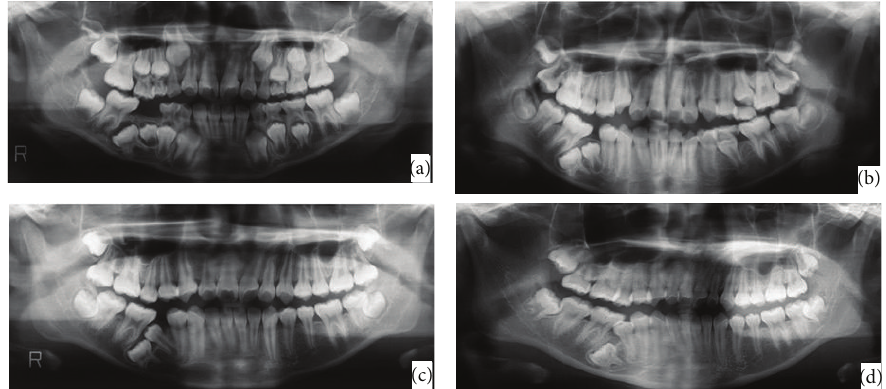
Figure 6: Panoramic radiographs showing growth changes of the dental germ: case 2. The formation stages of the impacted permanent tooth were approximately (a) Ri at age of 9 years and 2 months, (b) R1/2 at age of 11 years and 0 months, and (c) R3/4 at age of 12 years and 6 months. (d) At age of 16 years and 7 months, most of the tooth crown of the second permanent premolar had erupted, but the second primary molar remained